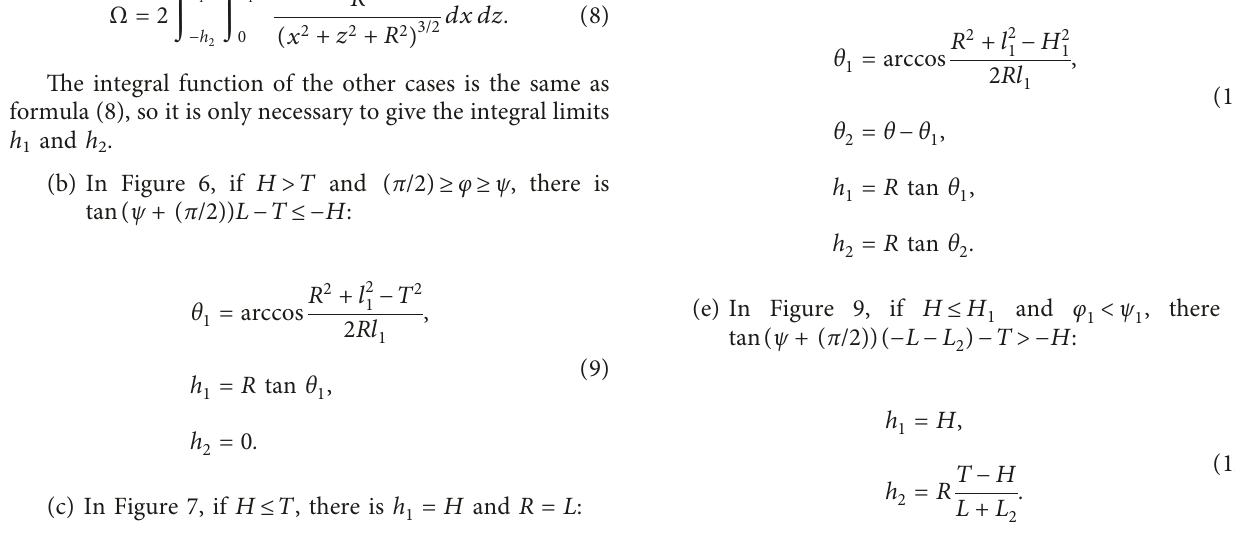
Figure 5: The condition at S